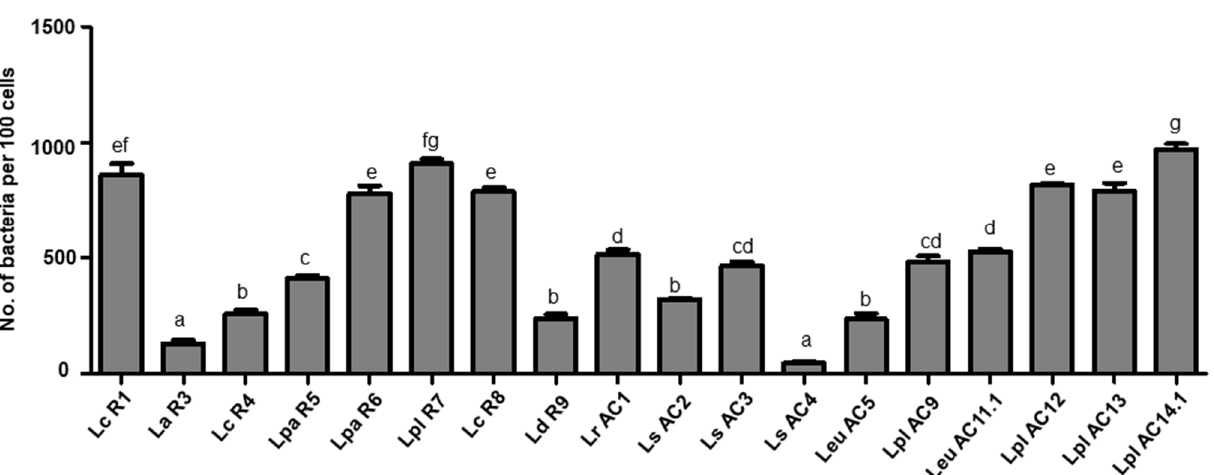
Figure 6. Adhesive ability of selected LAB isolates to Caco-2 cells. Graph bars marked with different letters on top represent statistically significant results. The results were compared by one-way ANOVA and Turkey post hoc test; p < 0.05; n = 2. Lc, L. casei; La , L. acidophilus; Lpa , L. paracasei; Lpl , L. plantarum; Ld , L. delbrueckii; Lr , L. rhamnosus; Ls , L. sakei; Leu , Leu. mesenteroides.